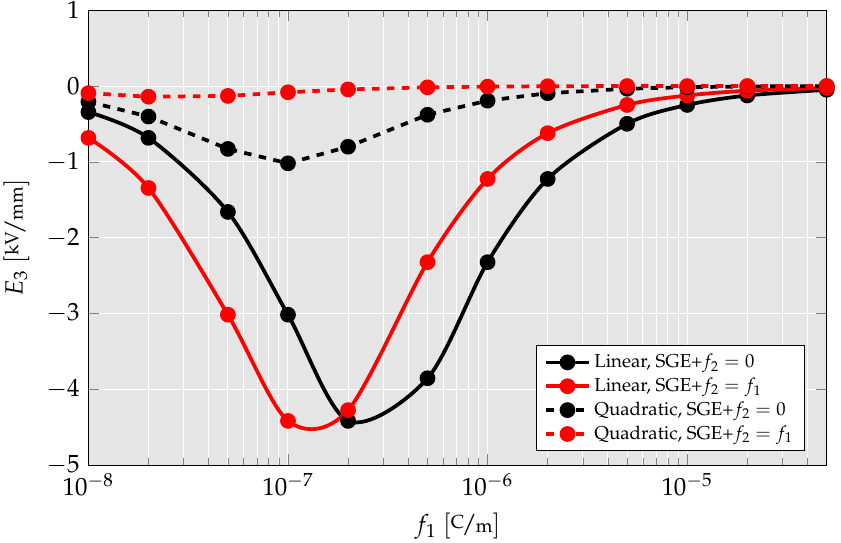
Figure 25. Maximum electric field E 3 of the cantilever beam calculated by using quadratic element for various flexoelectric coefficients.